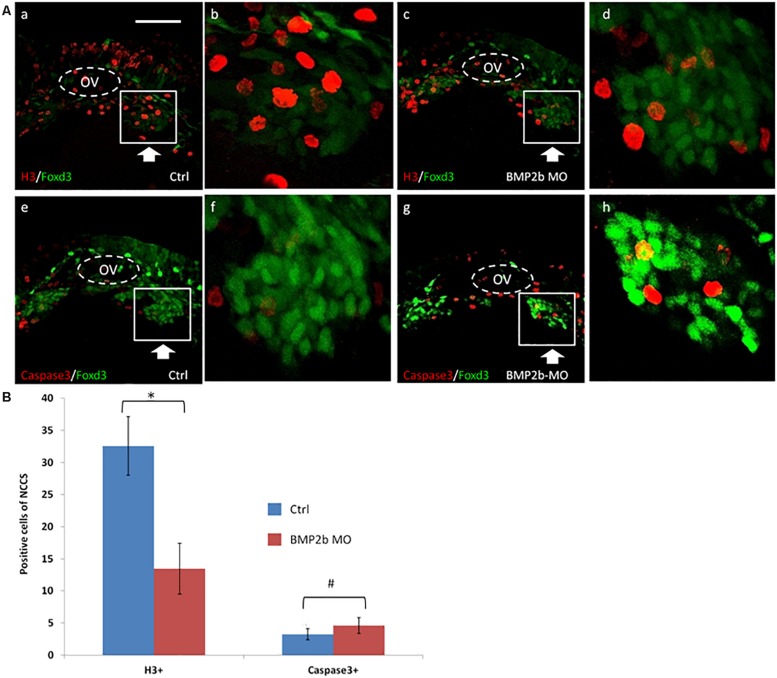
Proliferation but not apoptosis was changed in vagal NCC and ENS NCC in BMP2b morphants. Here we selected the areas included in the squares to count the positive cells, and the square areas were magnified on the right side of each image. (A,b,f) Lateral views of the vagal region of 30 hpf wild type(11/11, 100%)and (A,d,h) BMP2b MO treated (29/33, 87.9%)Foxd3:GFP transgenic embryos. Embryos were double stained with anti gfp (green) to study the distribution of vagal NCC and ENS NCC’s, anti caspase 3 (red) (A,e,h) to confirm apoptotic cells and, anti phosphohistone H3 (red) (A,a,d) to reveal proliferating cells. OV means otic vesicle. Large arrowheads pointed to the stream of vagal NCC. White boxes include the region that is shown in close up in the insert. Small white arrowheads point to the proliferating cells. (B) The NCC proliferation in the ctrl group is approximately 2.3 fold the H3+ cells of BMP2b MO group. The NCC apoptosis in the ctrl group is approximately 0.87 fold the Caspase3+ cells of BMP2b MO group. Values are given as mean ± SE. n = 6, t-test, ∗P < 0.05, compared with BMP2b MO group; #P > 0.05, compared with BMP2b MO group. Bar, 100 μm.